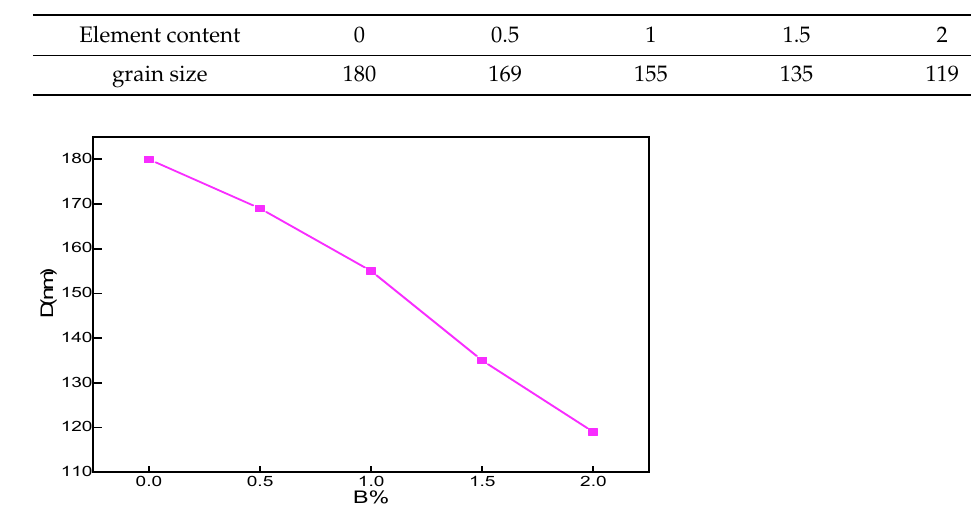
Figure 3. Grain size diagram of different nitrogen content. Table 3. Austenite grain size with different boron content (nm).